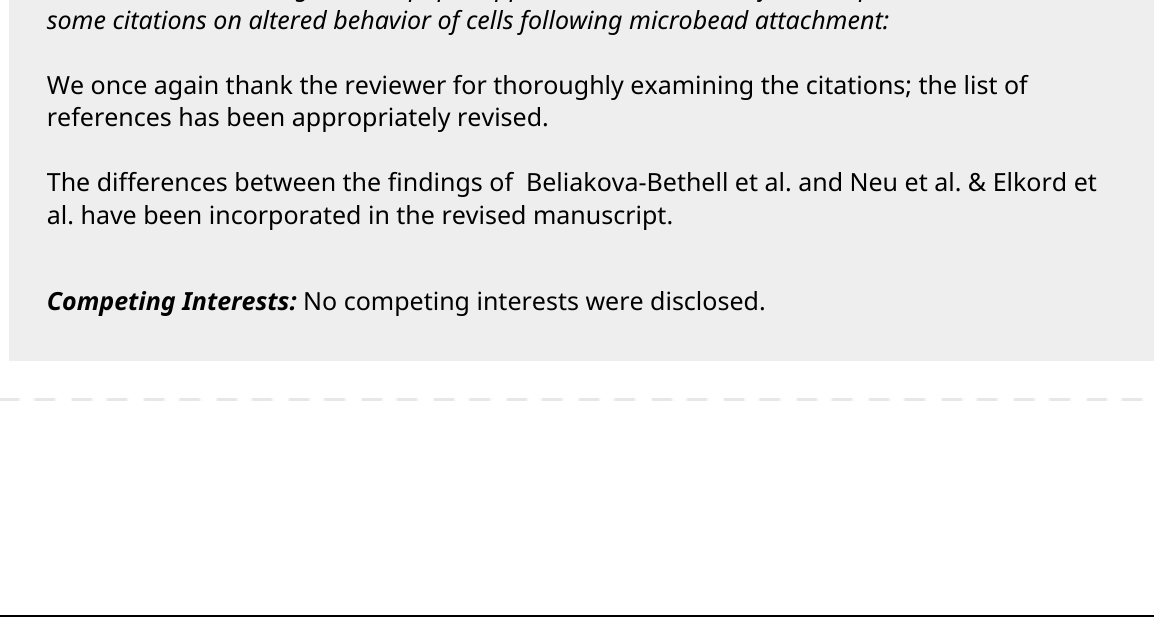
Data for Figure 2: were 36 fields for each sample for each time point individually counted, as the information on the figure indicates? Raw data appears to have only the averages. Was the distribution of counts tight, or was there high variation? Including raw data for individual field counts might be more appropriate